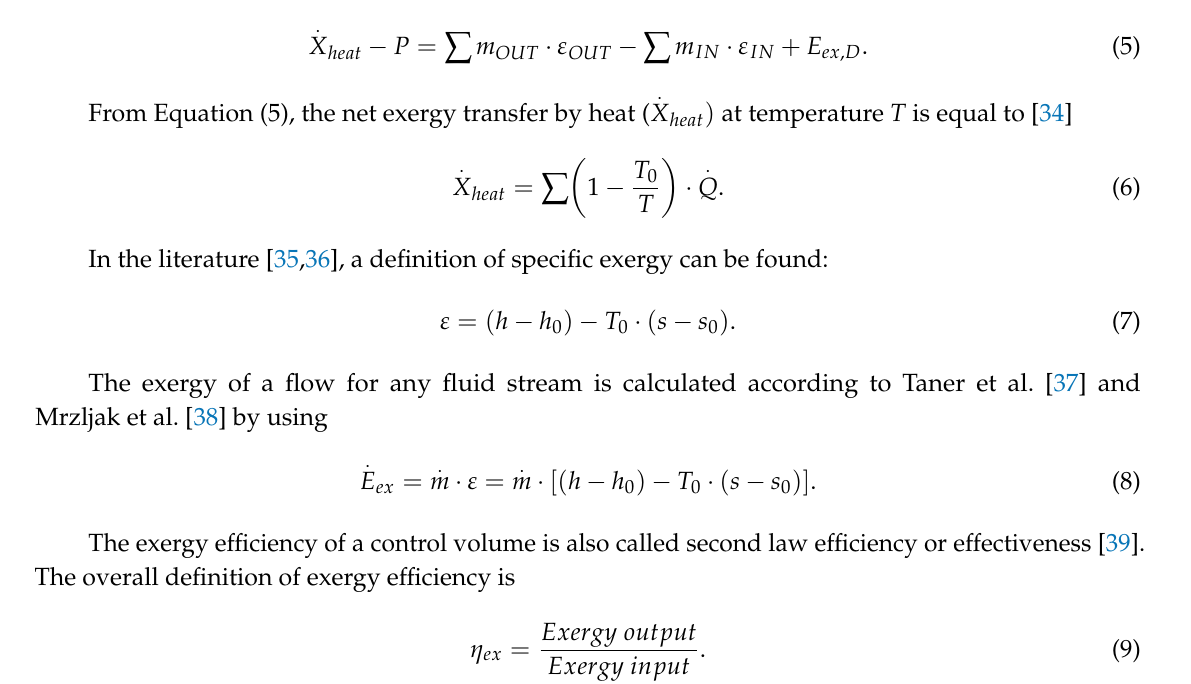
Figure 3. From the measured pressures and temperatures for each fluid stream, specific enthalpies and entropies were calculated using NIST REFPROP 8.0 software [40]. Mass and energy and exergy balances for the analyzed steam air heater are presented